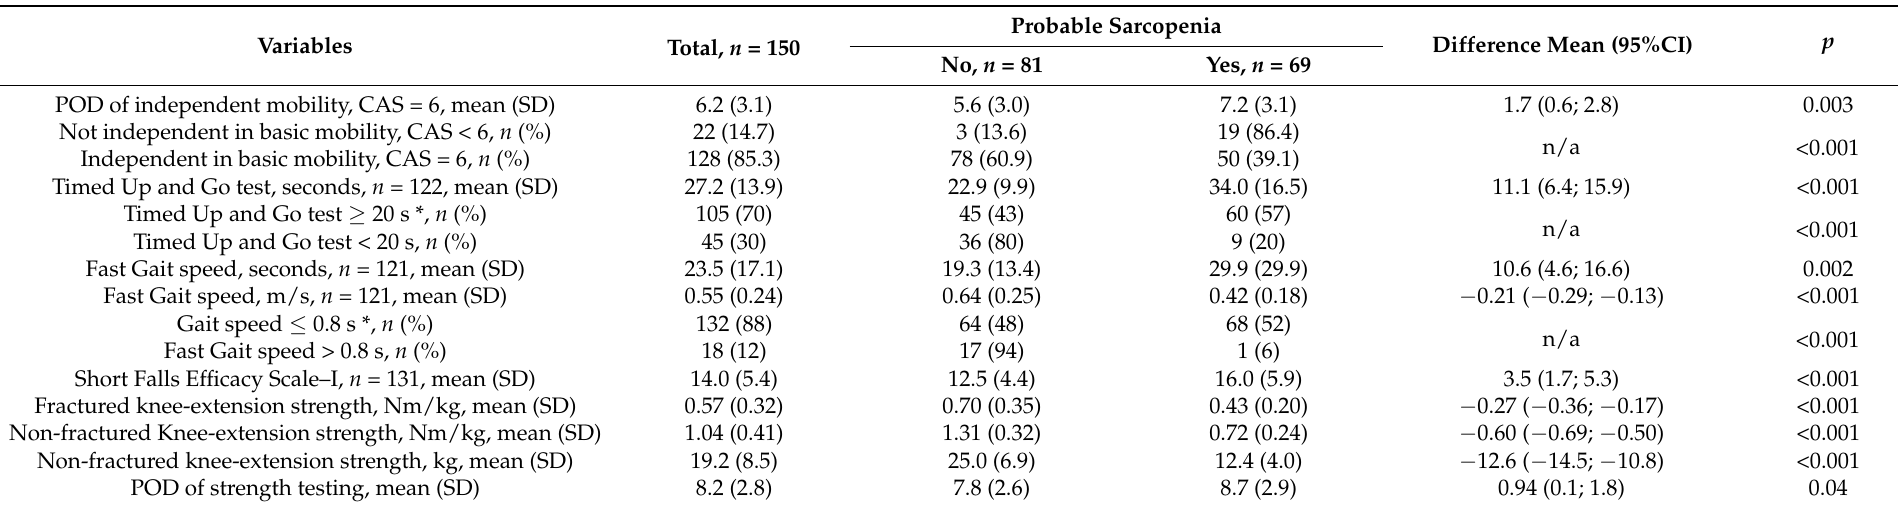
Table 3. Health-related outcomes of patients with hip fracture with a sex-specific probable sarcopenic status according to their knee-extension muscle strength measures. Variables Total, n =